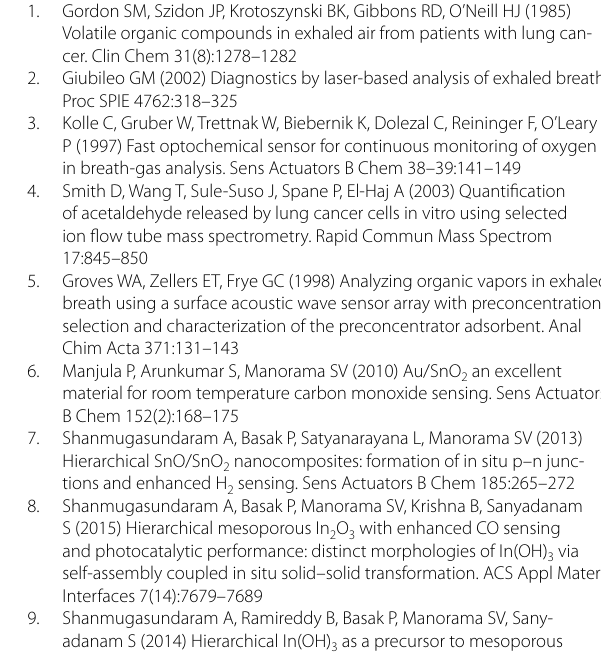
Table 1 Heptane and decane sensing characteristics of SnO